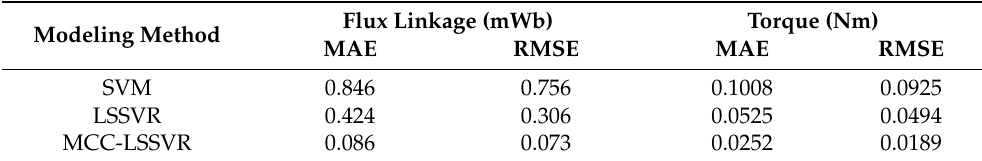
Table 3. Comparison of modeling accuracy of several